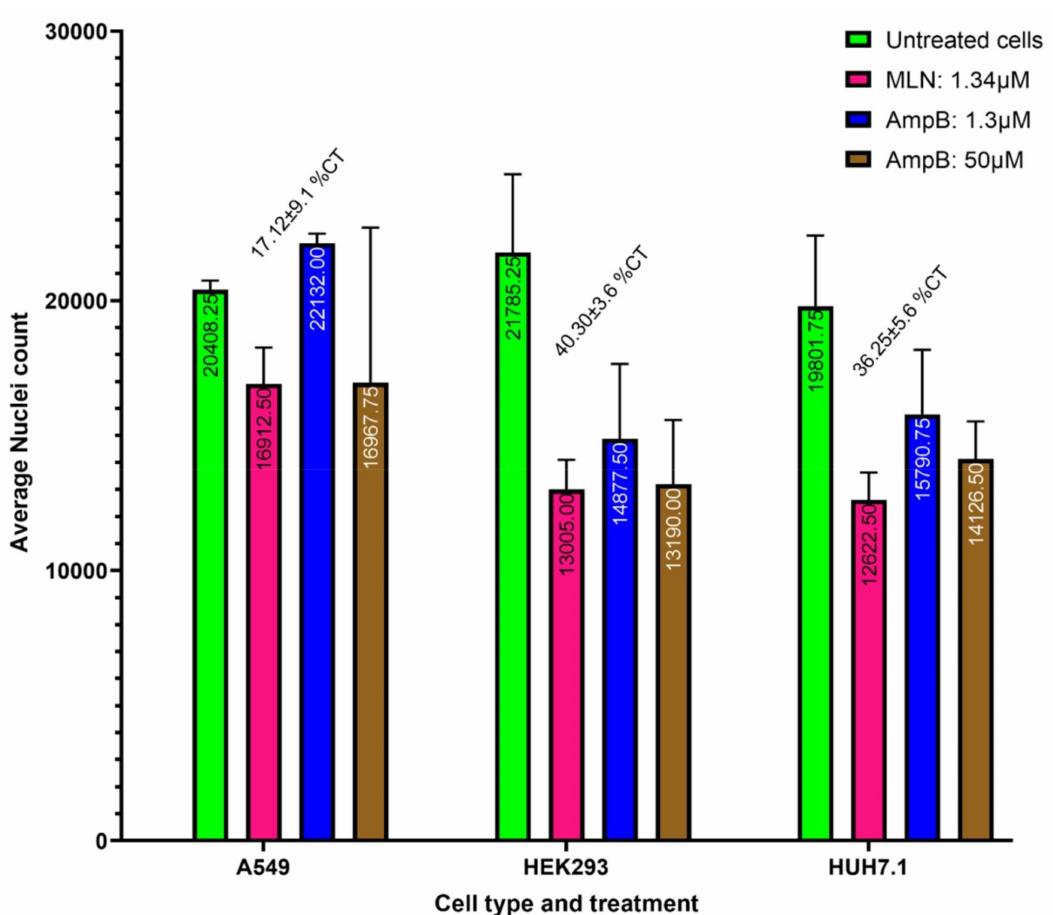
Figure 7. MLN cytotoxicity/cytostatic effect against different cell lines at maximum concentration tested (1.34 µ M). MLN exhibited high variability in toxicity among the different cell lines. [A] Cy- totoxicity (CC50 value) against Human alveolar cell line A549 was 17.12 ± 9.1%. [B] Cytotoxicity against immortalized Human fetal renal cell line HEK293 was 40.30 ± 3.6%. [C] Cytotoxicity against Human hepatoma cell line Huh7.1 was 36.25 ± 5.6%. This makes the cytotoxicity IC 50 breakpoint ratio versus anti-SARS-CoV-2 activity more than 65 ×